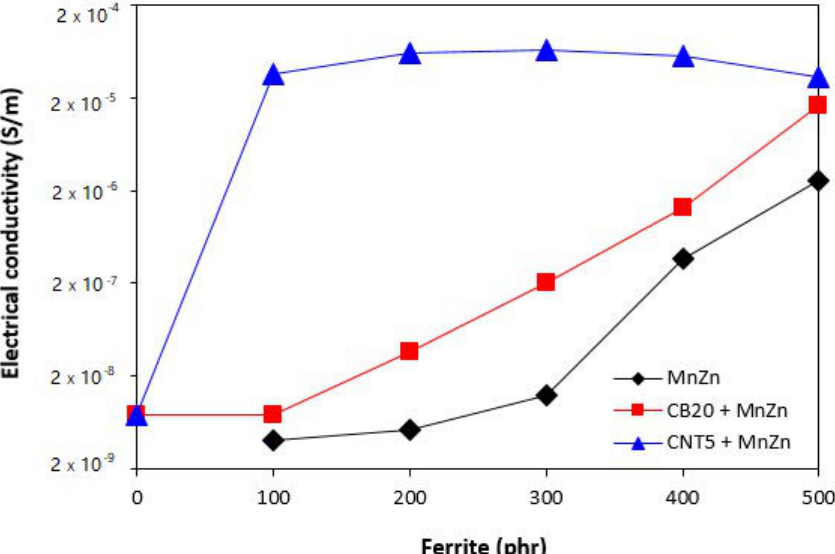
Figure 10. Electrical conductivity of